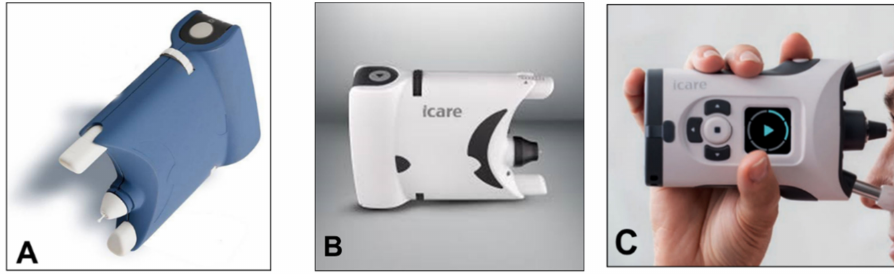
Figure 14. ( A ) iCare One; ( B ) iCare Home; ( C ) iCare